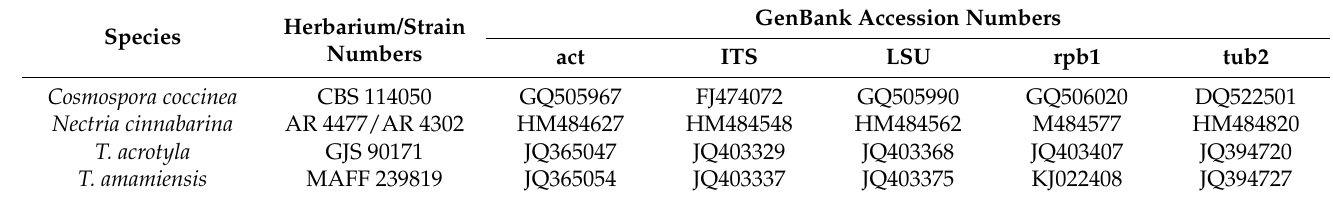
Table 3. List of Thelonectria species, herbarium/strain numbers, and GenBank accession numbers of materials used in this